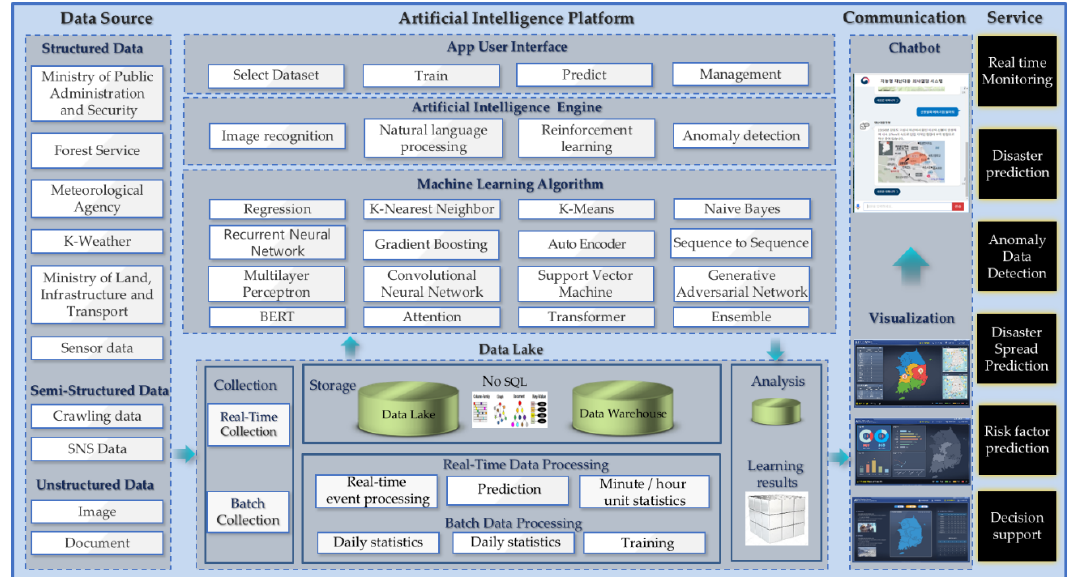
Figure 4. System using big data and AI for intelligent decision support.